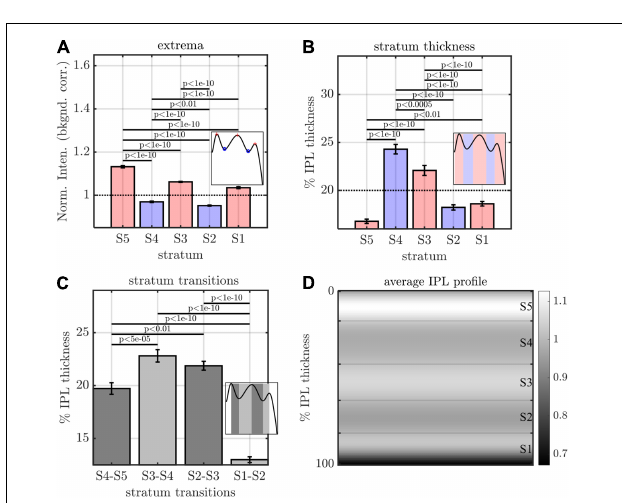
FIGURE 4 | Image analysis of IPL lamination parameters across 96 images (16 eyes × 6 high quality radial images), derived from the averaging and fitting procedure shown in Figure 2 . (A) A stereotyped reflectivity pattern is consistently observed. Stratum thickness (B) and inter-stratum transitions (C) suggest a broadening around S3–S4. (D) Average image profile (shown as intensity image) clearly depicts the major features (i.e. high intensity or prominent S5, broad S3 and S4, narrow S1 and S5. Horizontal lines denote stratum